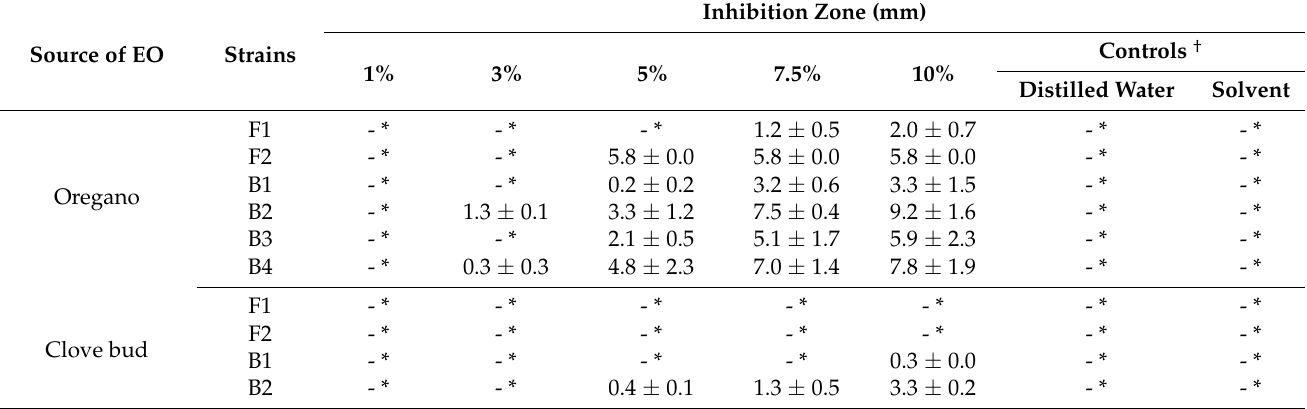
Table 3. Effect of tested essential oils (low concentration) on microbial strains isolated from Buyeo Royal Tomb No.